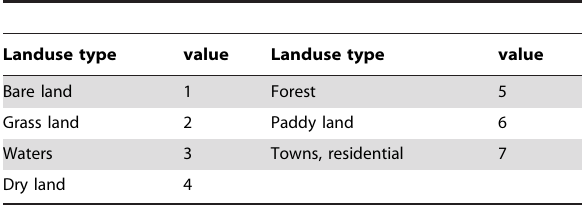
Table 4. The quantified result in accordance with the land use pattern.